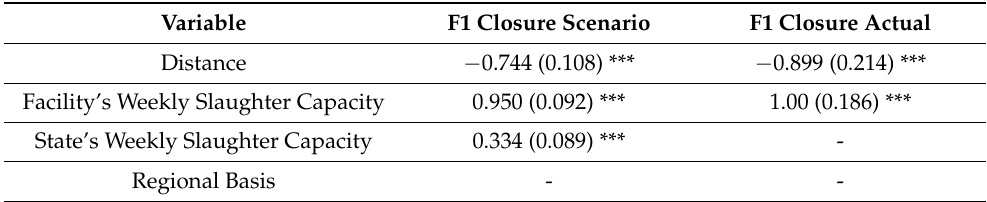
Table 2. Results of model validation for F1 closure. Results reported as regression coefficient (Standard Error), p < 0.001